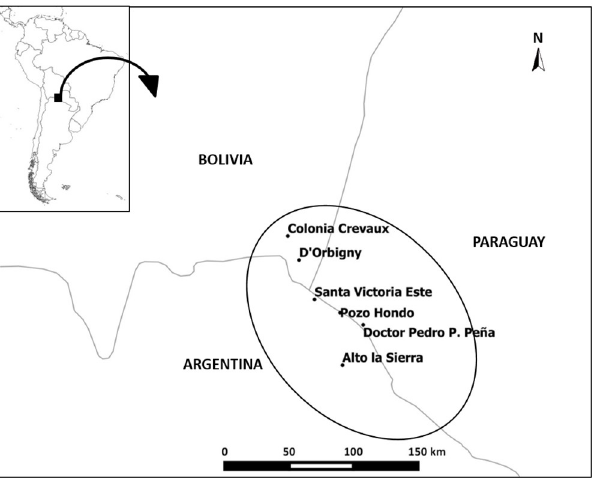
Fig 1. Map of the localities included in the intervention program. Santa Victoria Este and Alto la Sierra in Argentina, Colonia Crevaux and D´Orbigny in Bolivia, and Pozo Hondo and San Agustı´n/Doctor Pedro P. Pe ñ a in Paraguay. Map created with QGIS 2.4 open-source software.